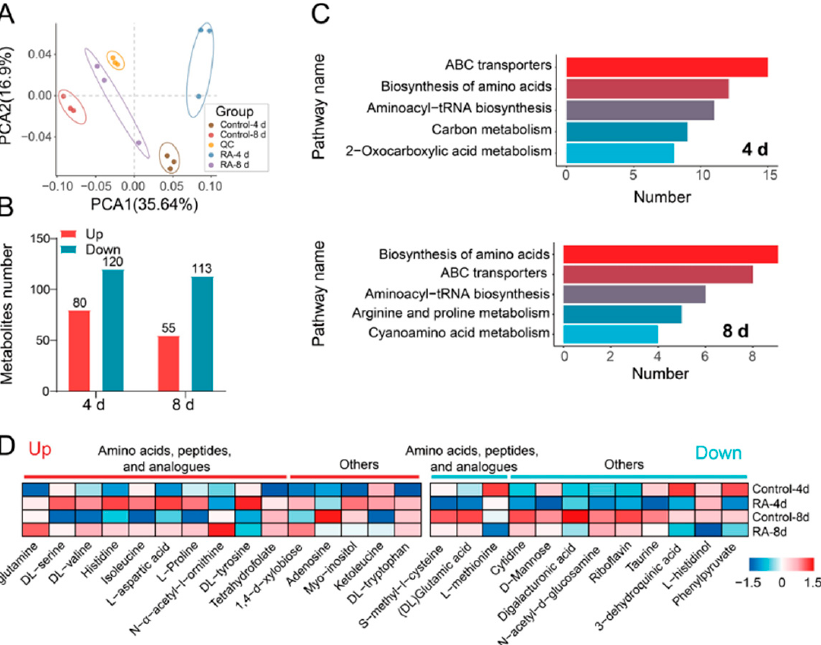
Figure 7. Effects of RA treatment on fruit metabolome. ( A ) PCA of metabolites as influenced by RA treatment at 4 and 8 d. ( B ) Number of metabolites increased or decreased by RA treatment at 4 and 8 d, respectively. ( C ) Top 5 enriched KEGG pathways based on RA-regulated differentially accumulated metabolites (DAMs) at 4 and 8 d, respectively. ( D ) Heatmap indicates the relative metabolite abundance of RA-regulated DAMs within the top 3 enriched KEGG pathways of ABC transporters, the biosynthesis of amino acids, and the aminoacyl-tRNA biosynthesis. The original metabolite abundance was subjected to data adjustment by normalization using an R package. Red and blue lines indicate the up- and down-regulated metabolites by RA treatment at 4 and 8 d, respectively. The color scale on the right indicates relative metabolites abundance.